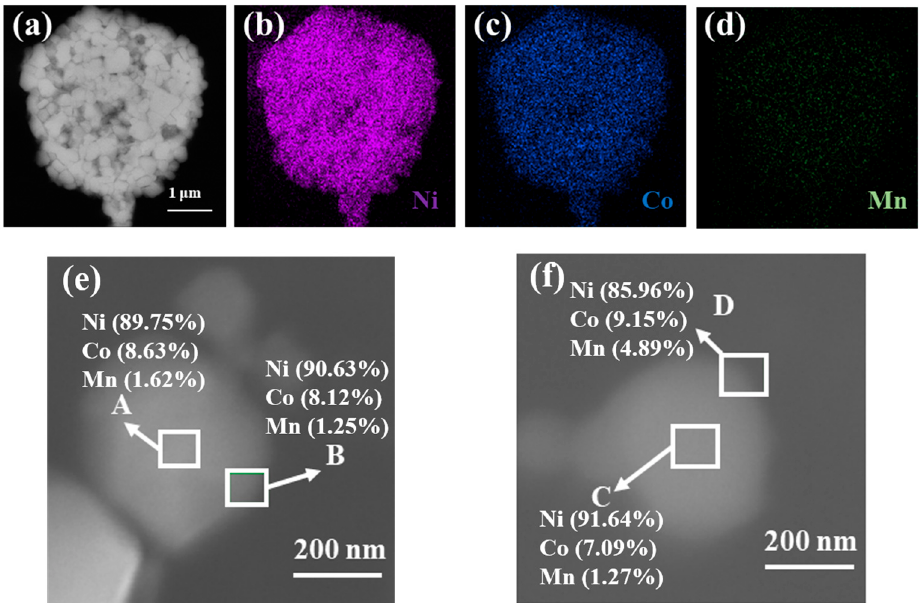
Figure 3. SEM image of cross-section of ( a ) CG-LNCM and the corresponding EDX elemental mappings of ( b ) Ni, ( c ) Co and ( d ) Mn; SEM images of primary particles and compositions of the selected area of ( e ) CC-LNCM and ( f ) CG-LNCM.